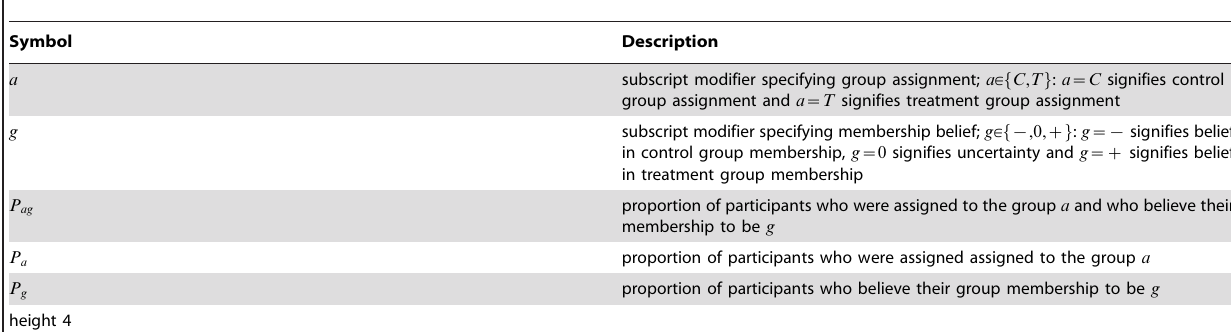
Table 1. Notational convention for mathematical symbols adopted in this paper.